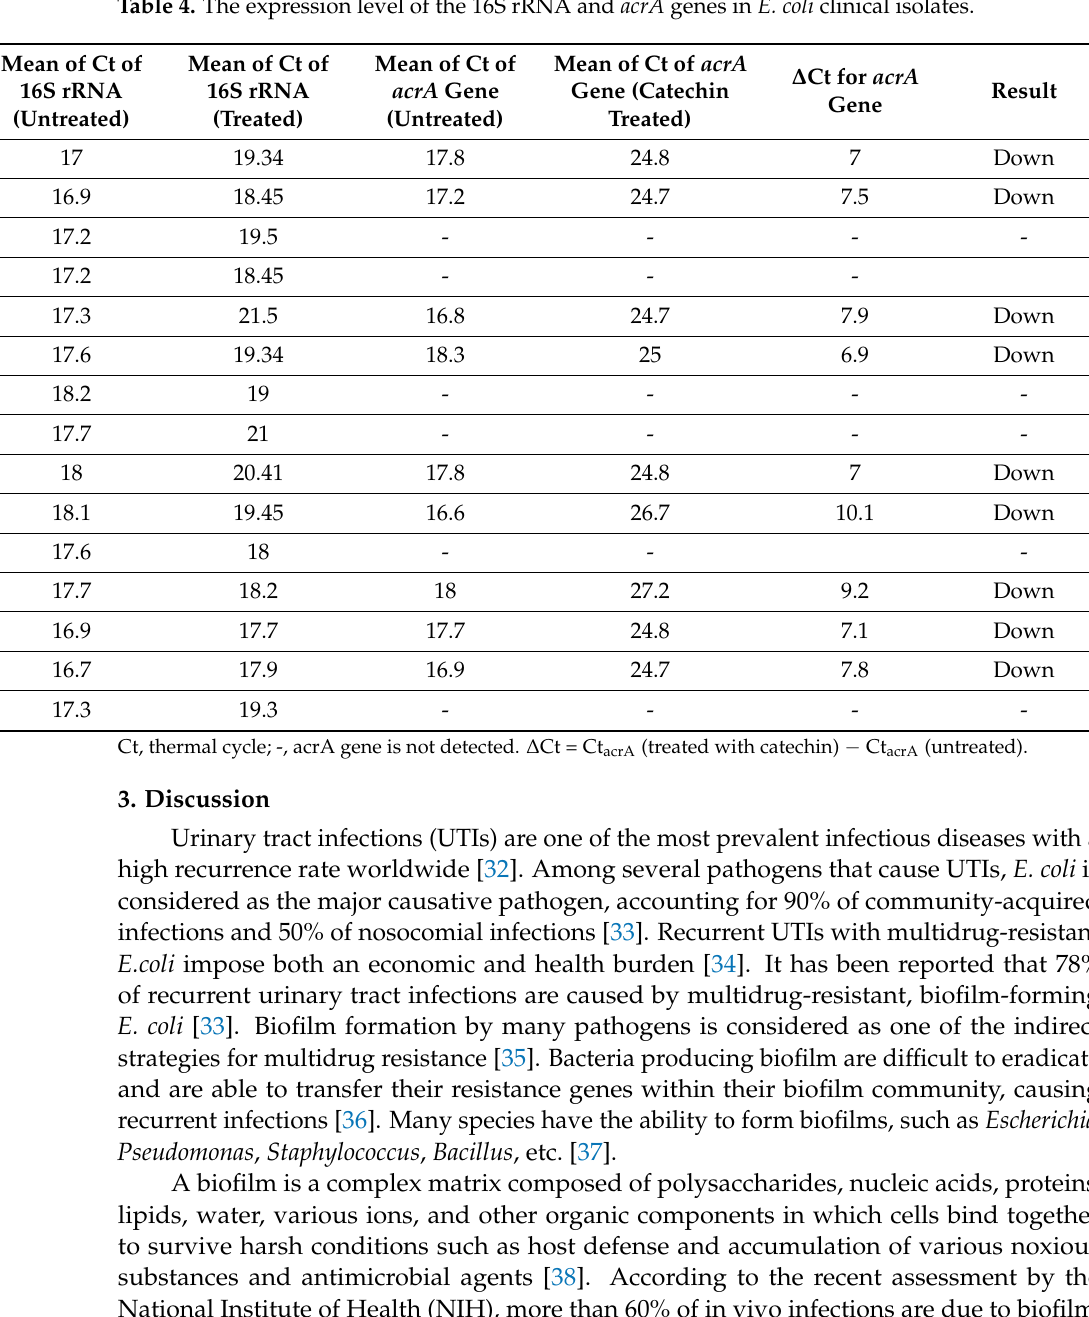
Table 4. The expression level of the 16S rRNA and acrA genes in E. coli clinical